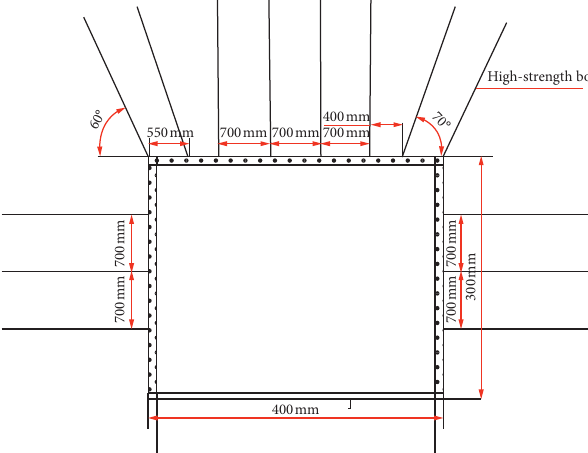
Figure 3: Roadway support schemes.